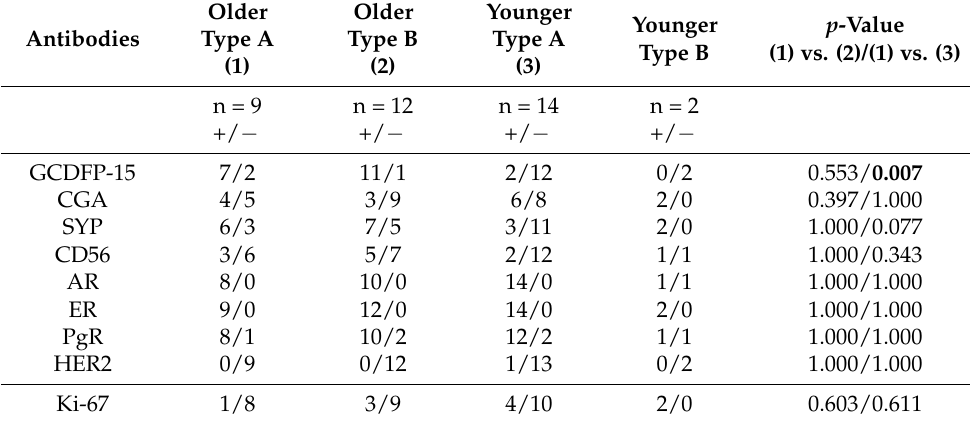
Table 5. Immunohistochemical features of carcinomas among four